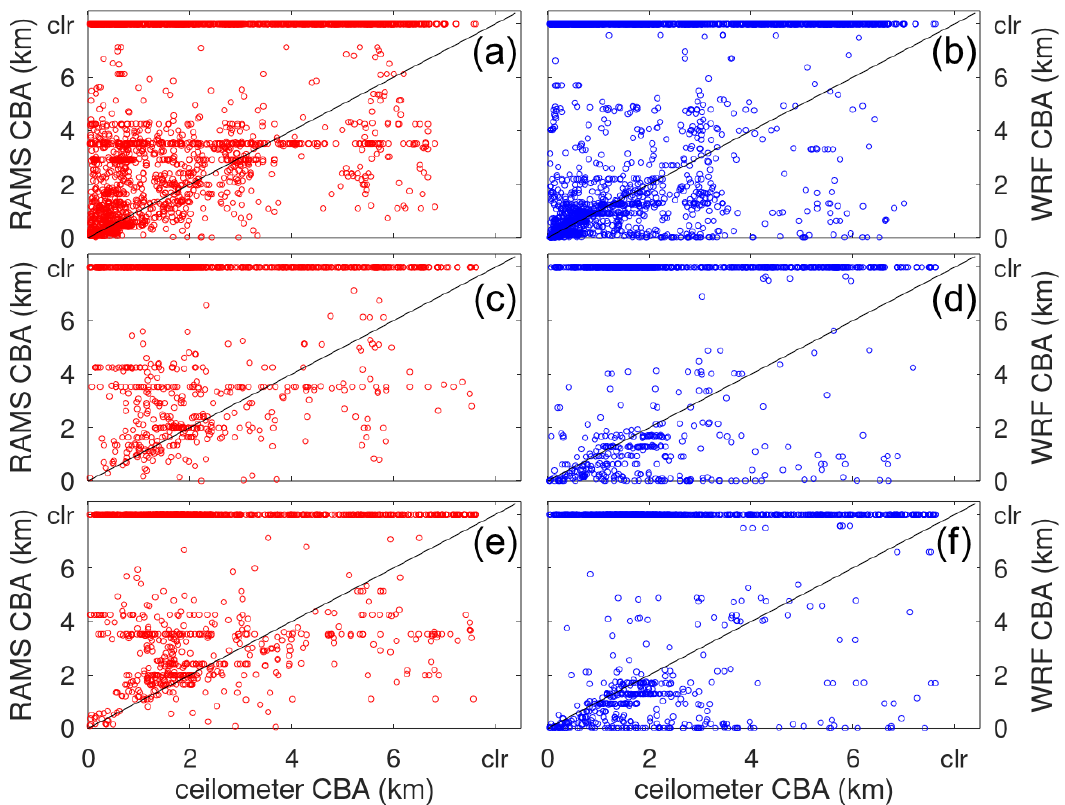
Figure 10. Plots of CBA separated by ceilometer CF; ( a , b ) CF > 0.8; ( c , d ) CF 0.4–0.8; ( e , f ) >0–0.4. RAMS is on the left (red) and WRF is on the right (blue). Clear sky for the models is indicated at the top of the plot. No ceilometer clear sky (CF = 0) is shown (see Table 2).